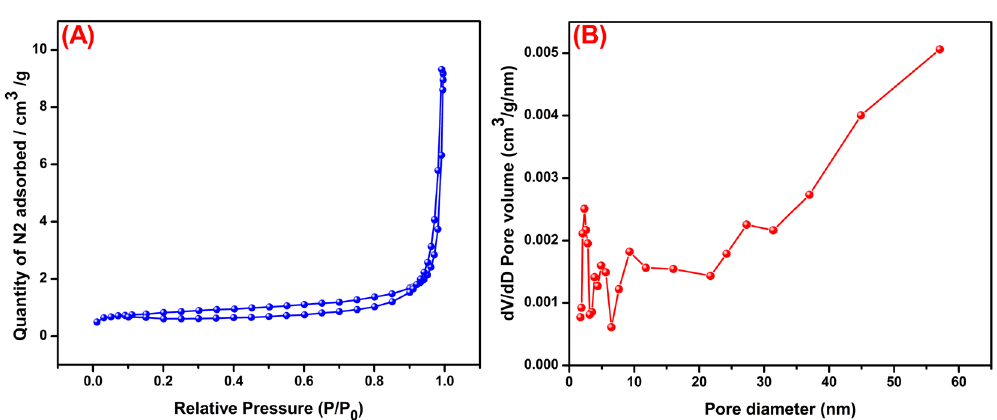
Figure 6. Nitrogen adsorption-desorption isotherms ( A ) and the pore size distribution plots ( B ) of rod-like SrV 2 O 6